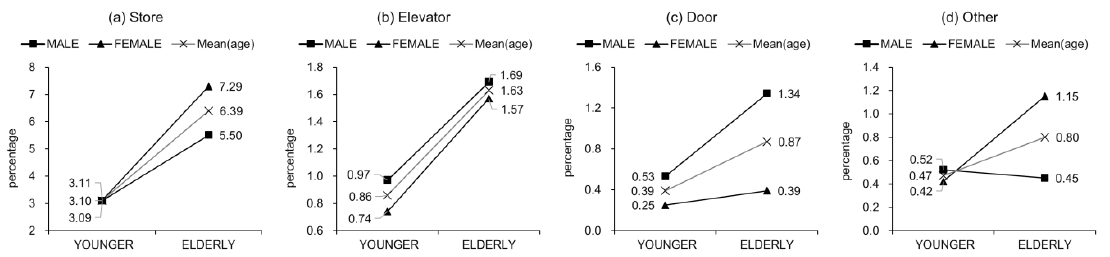
Figure 6. Results of visual attention on landmarks in Task 2.